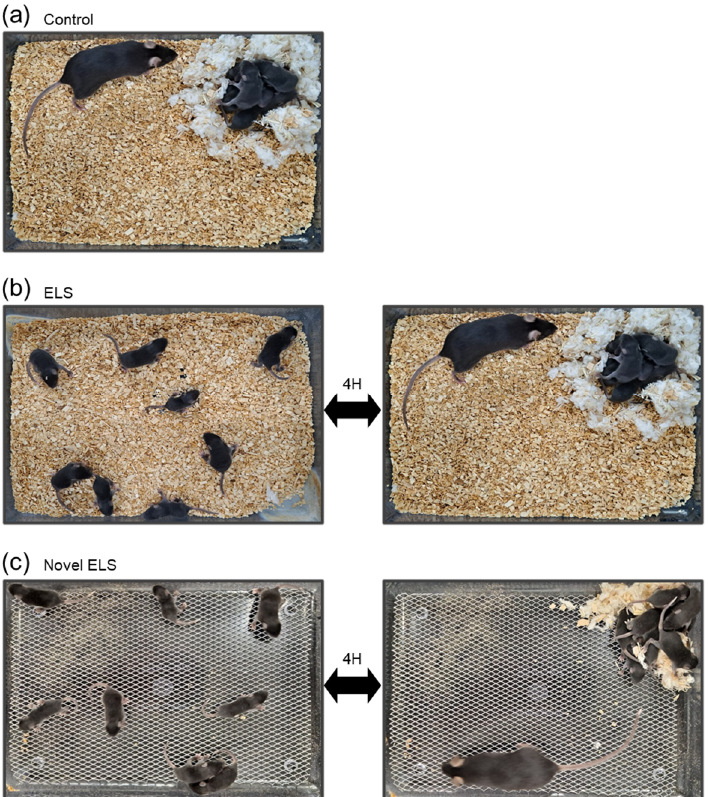
Figure 6. Photographs showing the setup of the early life stress (ELS) paradigm as compared to the control group cage. ( a ) The cage of the control group with a standard amount of sawdust bedding. ( b ) The cage of the established ELS group with a standard amount of sawdust bedding for the maternal separation paradigm. ( c ) The cage of the novel ELS group with a fine-gauge aluminum mesh platform without sawdust bedding.